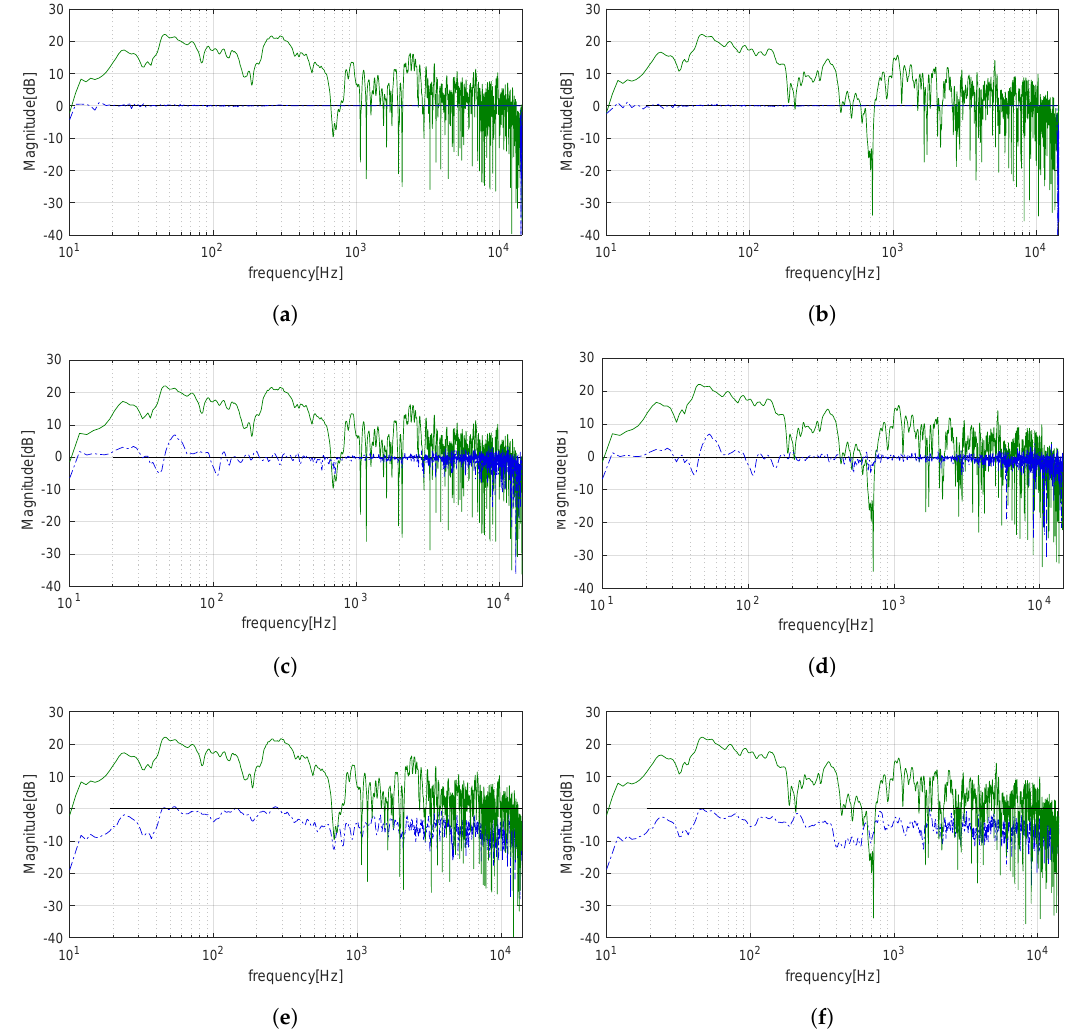
Figure 7. Magnitude frequency responses at the left and right microphones of the dummy head in the Alfa Romeo Giulia after applying filters obtained from the CNN ( a , b ), Frequency Deconvolution ( c , d ) and Steepest Descent ( e , f ) methods. The original magnitude frequency response is shown in green while the equalized frequency response is shown in blue. The target magnitude response is shown in